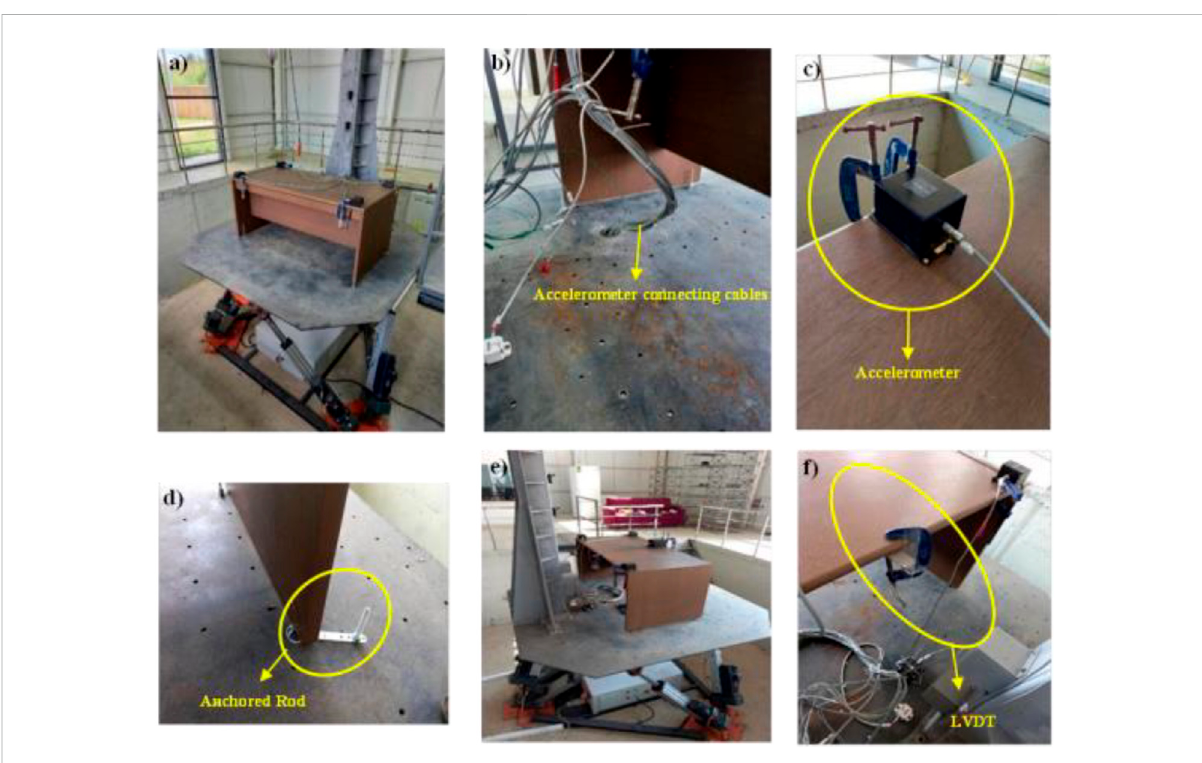
View of a table NE on the shake table (Cavuslu,